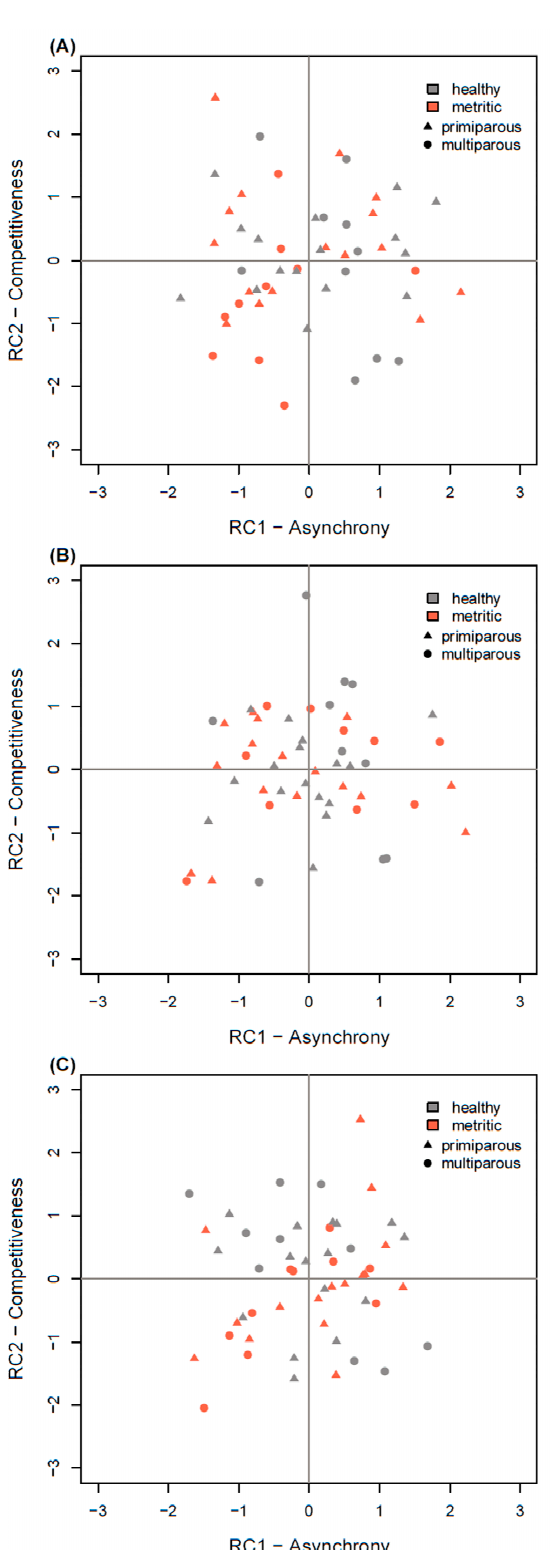
Figure 1. Principal component (RC) scores of healthy ( n = 26) and metritic ( n = 26) cows in 3 different periods ( A ): PRE: d − 6 to − 1 prepartum, ( B ): POST1: d 1 to 3 postpartum, ( C ): POST2: d 4 to 6 postpartum). Metritic cows were healthy during PRE and POST1 and diagnosed with metritis on d 6 postpartum. The RC scores of healthy and metritic cows did not show significant di ff erences in any period, but primiparous cows tended to have higher RC2 scores during